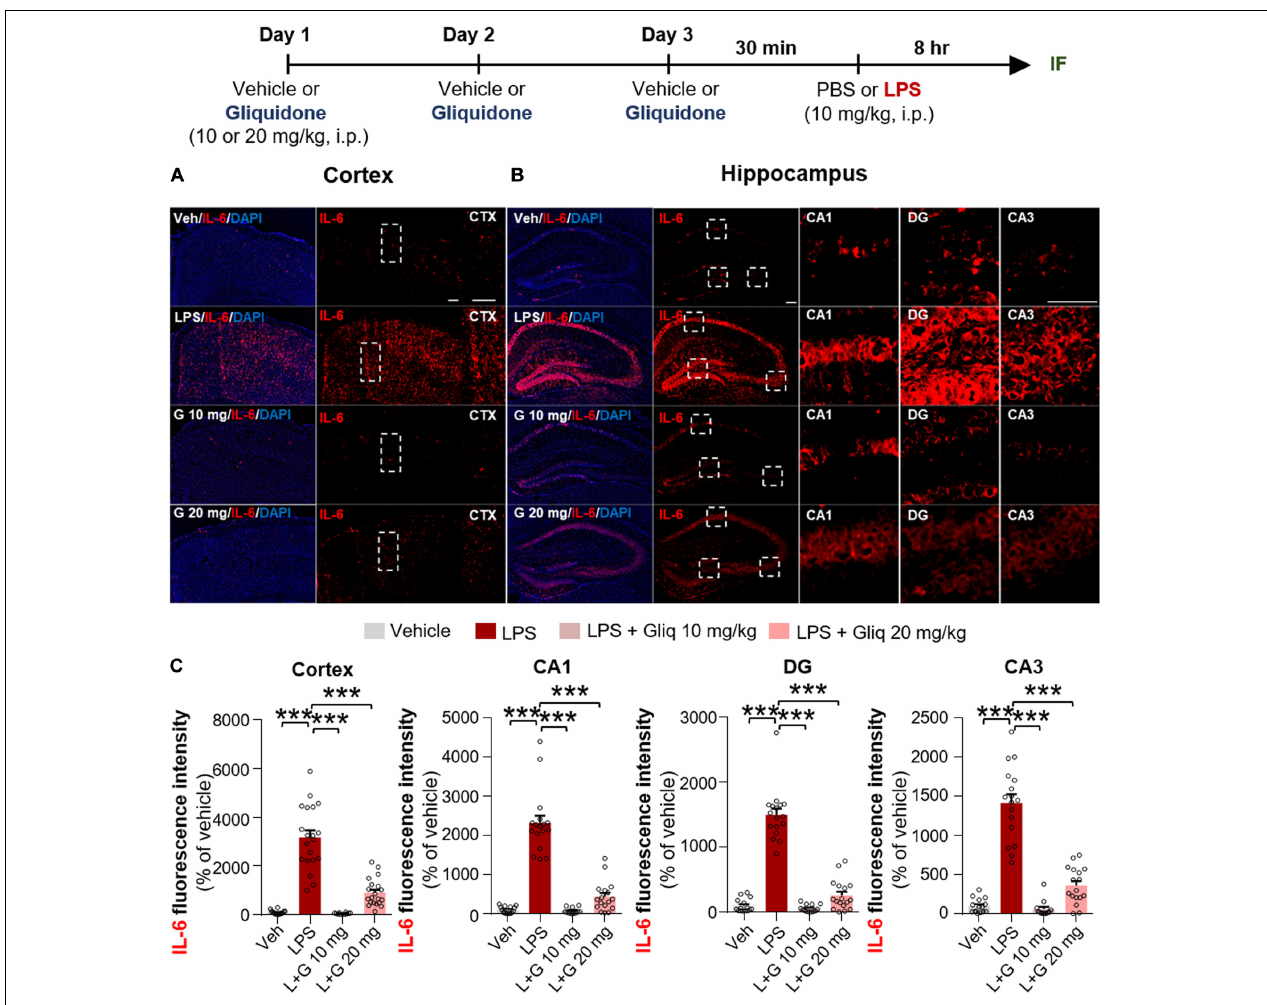
FIGURE 4 | Gliquidone eliminates the LPS-induced elevation of IL-6 levels in the brain in C57BL6/N mice. (A,B) Immunofluorescence staining of IL-6 expression in brain slices from mice treated as shown at the top of the figure. (C) Quantification of the results in (A,B) ( n = 12–20 brain slices from 4 mice/group). *** p < 0.001. Scale bar = 100 µ